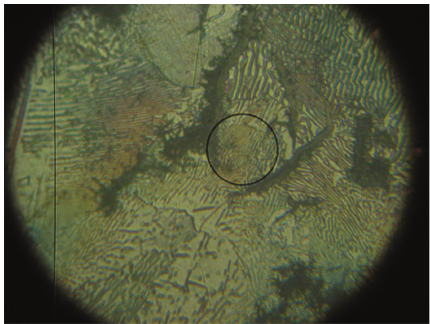
Figure 3: Microstructure in zone F 100x.